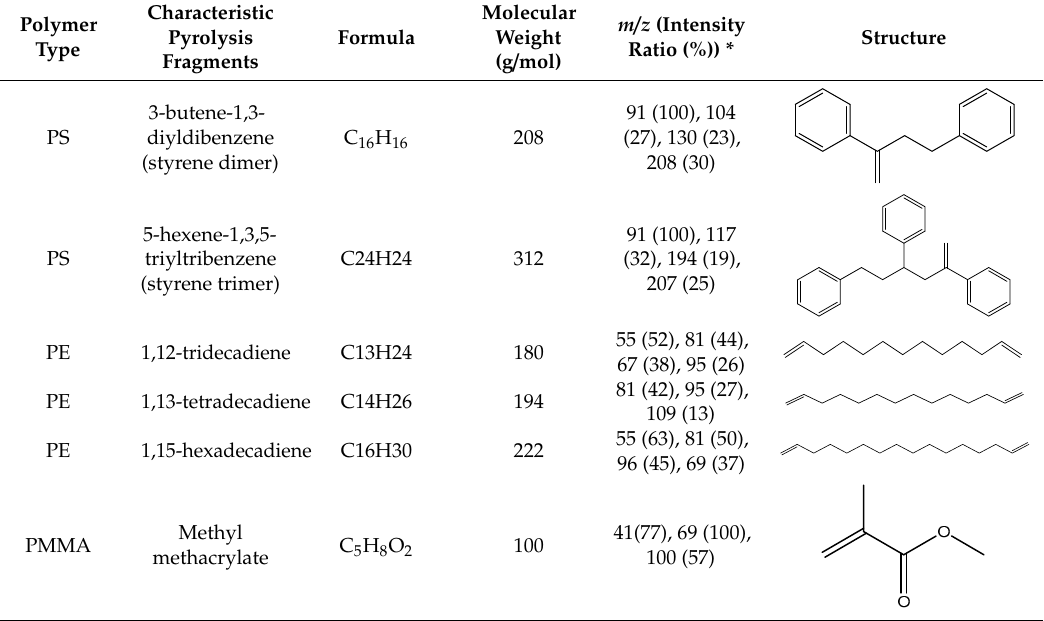
Table 1. Characteristic pyrolysis products of selected polymers for identification.